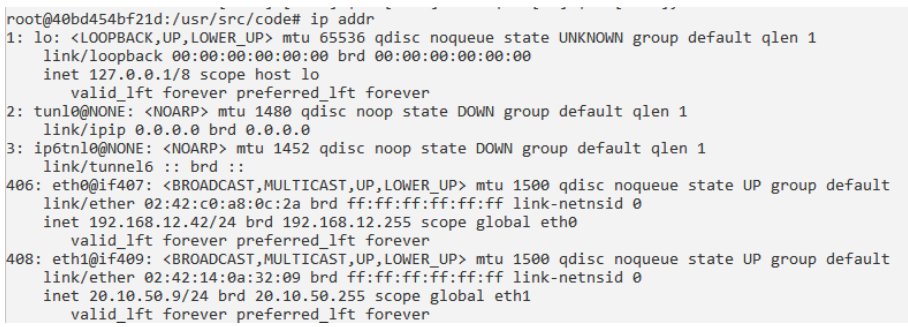
Figure 8. Checking the Network